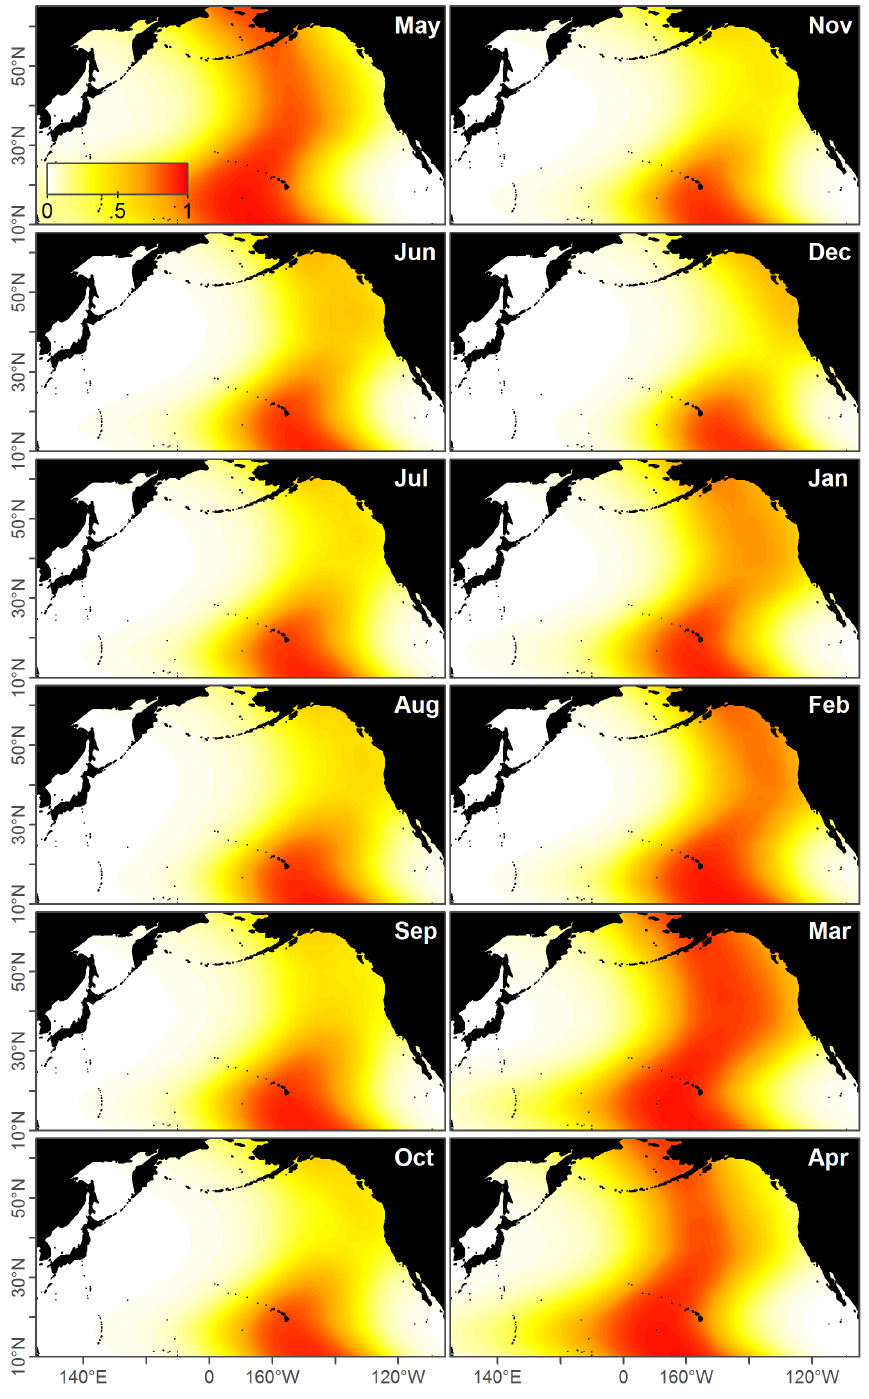
Figure 10. Maps showing the statistical uncertainty arising from bootstrapping. Uncertainty in the base case probability of a catch being from the ENP population quantified using bootstrapping (i.e. resampling the acoustic data with replacement and refitting the models). The z -axis is the range of the predictions (95th minus 5th percentile) across all 1000 bootstrapped models. A value of z ~ 0 indicates all bootstrap models predict the same value, while z ~ 1 indicates some bootstrap models predict 0 and others predict 1, so that there is high uncertainty at that location. There is higher uncertainty where overlap between the two populations exists (e.g. Gulf of Alaska) or there is limited data (e.g. Hawaii). doi:10.1371/journal.pone.0098974.g010 bootstrap sample could be used. A total of 1099 iterations of the GAMLSS model additive fits are interpreted by plotting the algorithm were needed to arrive at 1000 successful ENP catch smoothers fit to ‘‘partial residuals’’ which have an arbitrary absolute scale and instead are judged via the relative change series.